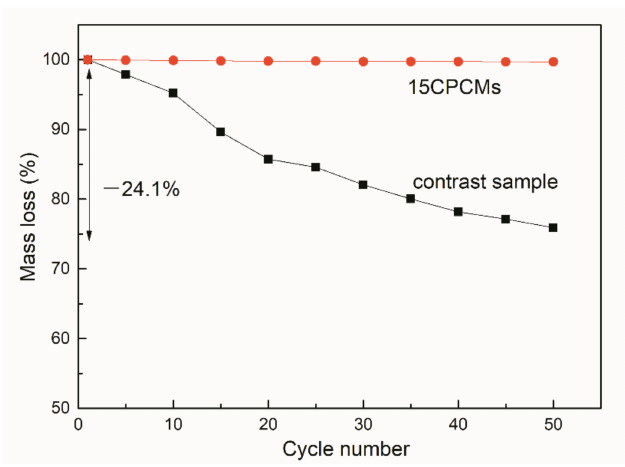
Figure 8. Weight loss curves of 15CPCMs and contrast sample.